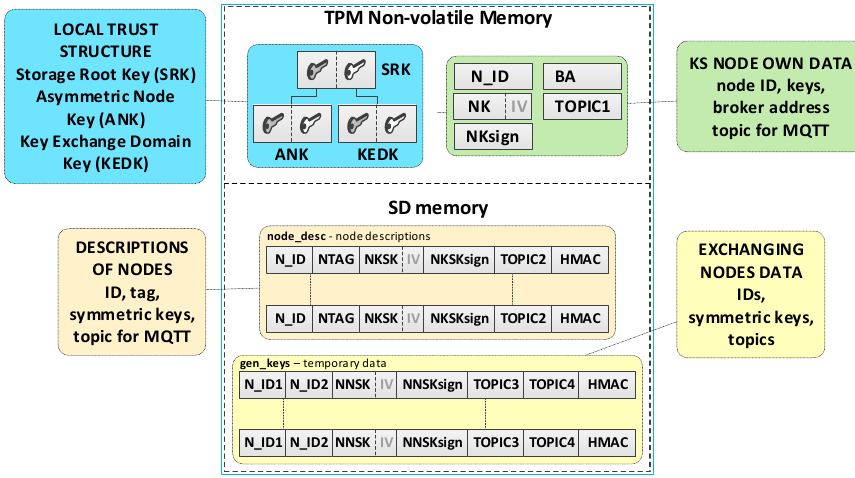
Figure 5. Data stored on the KS node.